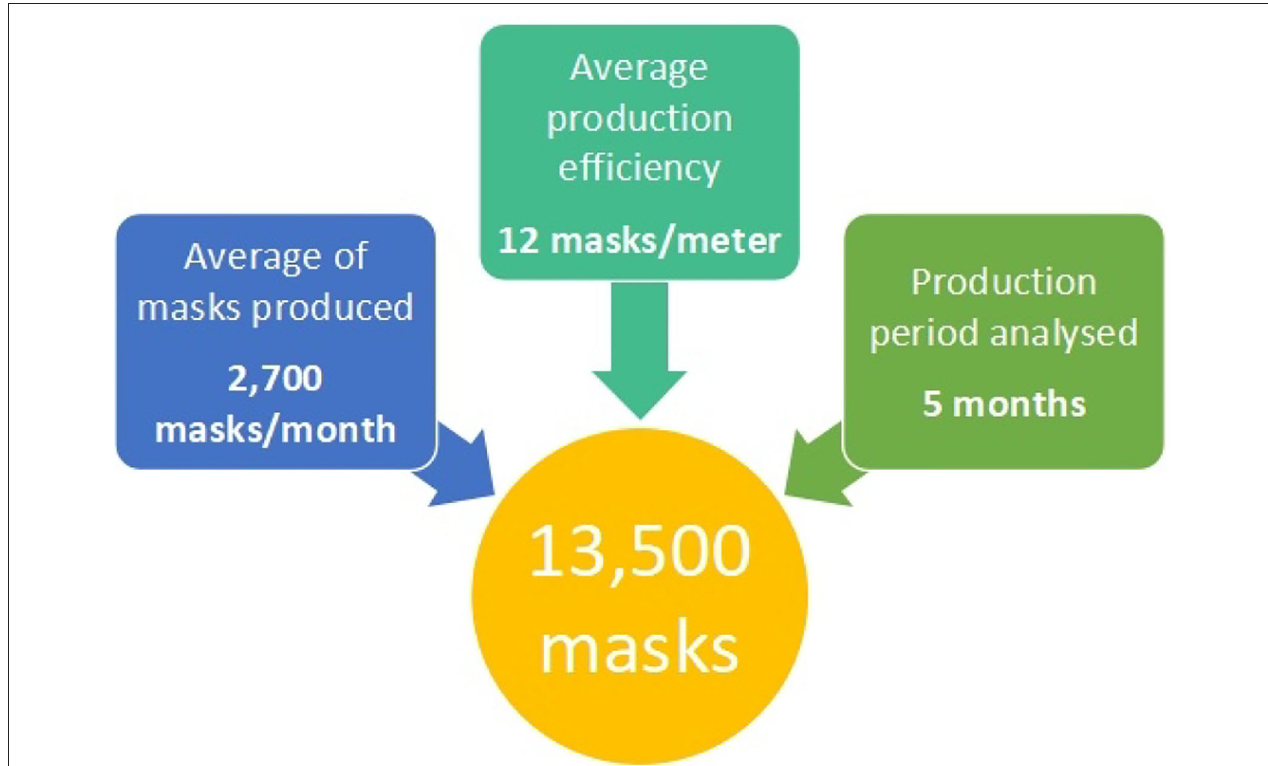
FIGURE 6 | Parameters used to calculate the estimated quantity of masks produced with remnants of fabric in